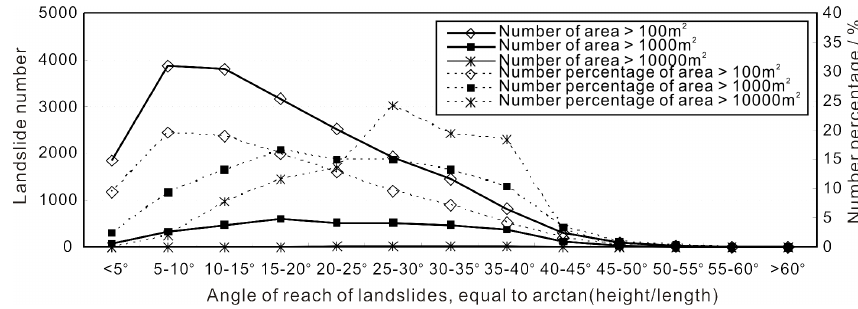
Figure 16. Landslide angle of reach [arctan(height/length)] distribution.